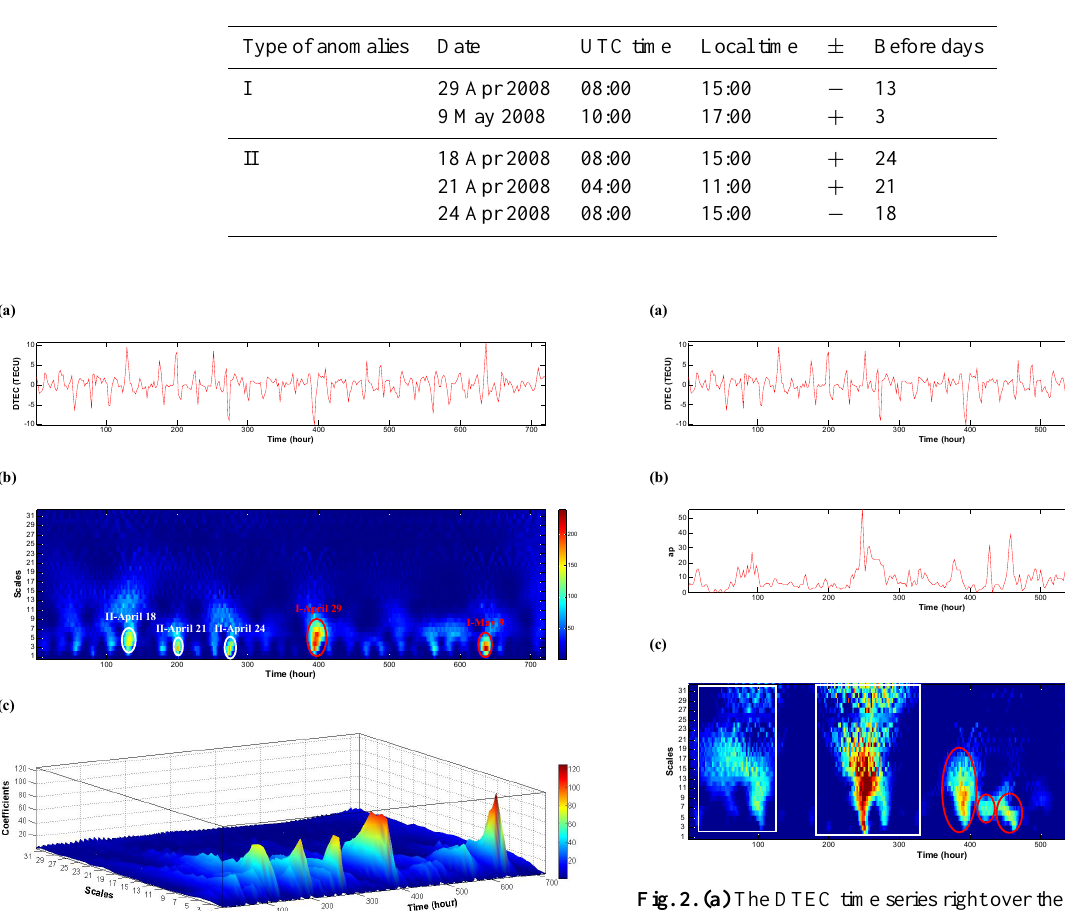
Table 1. Ionospheric perturbations before the Wenchuan earthquake detected by AWT and DTEC from 13 April to 12 May 2008. The + and − signs stand for the positive and negative perturbations detected by DTEC, respectively.